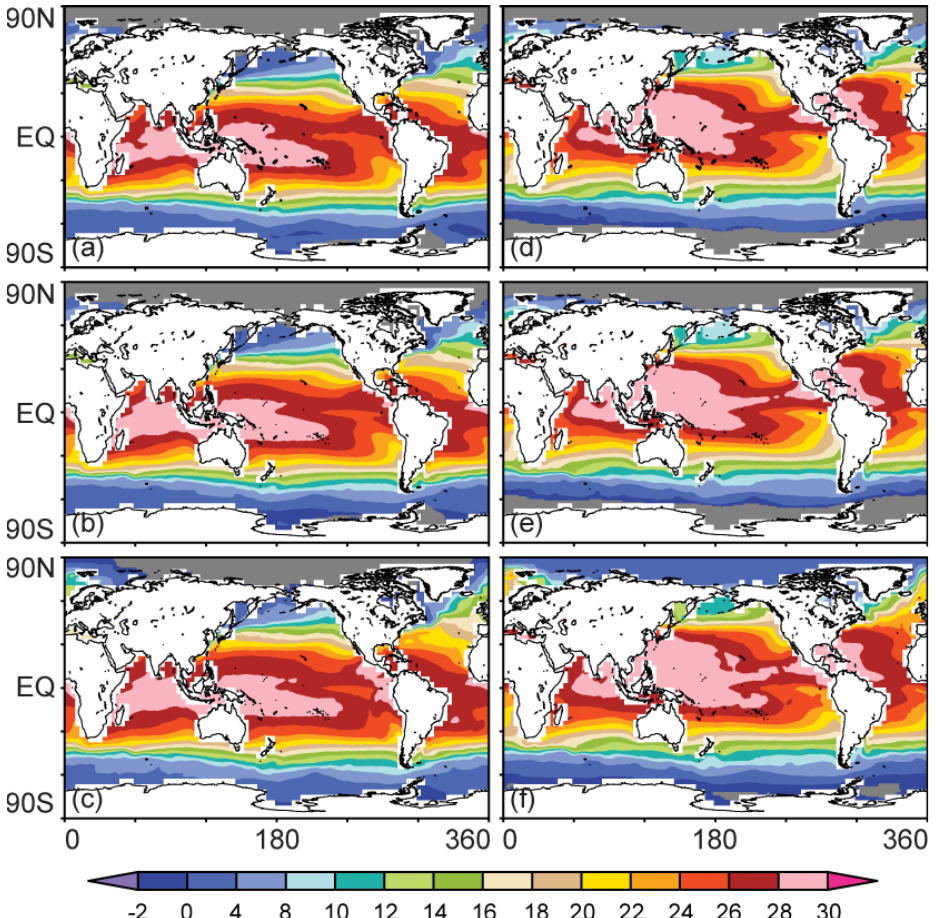
Fig. 1. SST ( ◦ C) and sea-ice fields used in the experiments, left column for February, and right column for August. (a) and (d) for monthly mean HadISST between 1879–1900. (b) and (e) for local modern SST. (c) and (f) for mid-Pliocene SST. Gray represents the area covered by